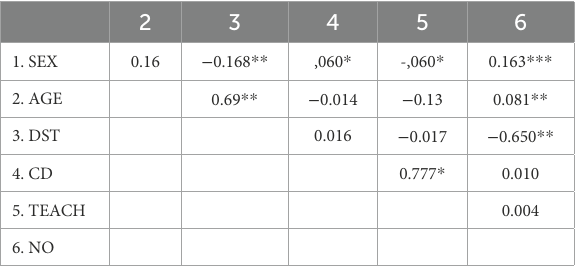
TABLE 3 Correlation